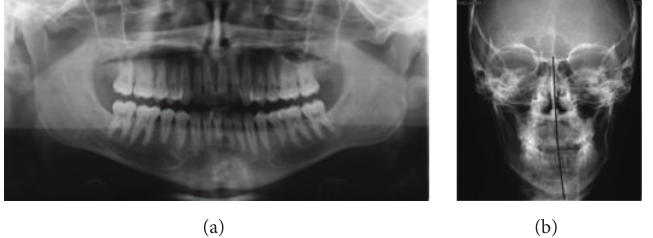
Figure 2: Preoperative radiological evaluation. (a) Orthopantomograph; (b) teleradiography of the skull in a posteroanterior projection.